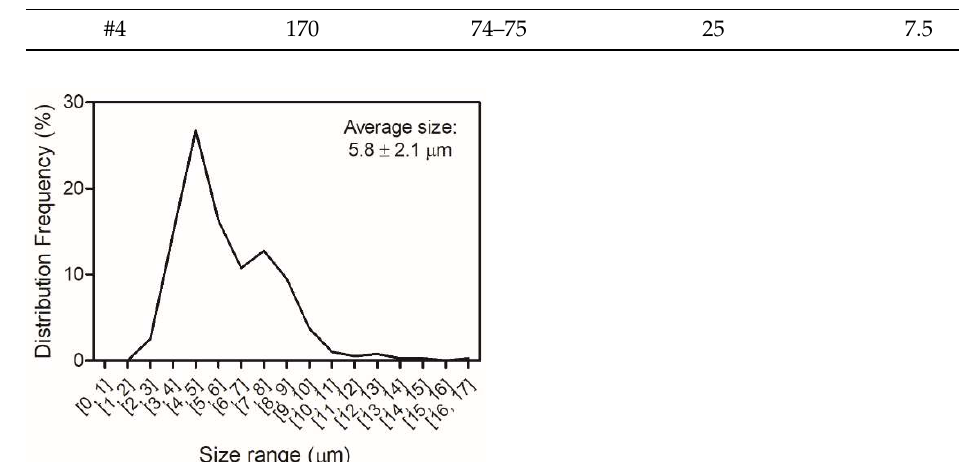
Figure 3. Akkermansia muciniphila DSM 22,959 microcapsules size relative distribution ( µ m). The average size is also presented. These values result from 400 independent measurements within the sample. Matrix: 10% skim milk; inlet/outlet temperatures: 150/65 °C.